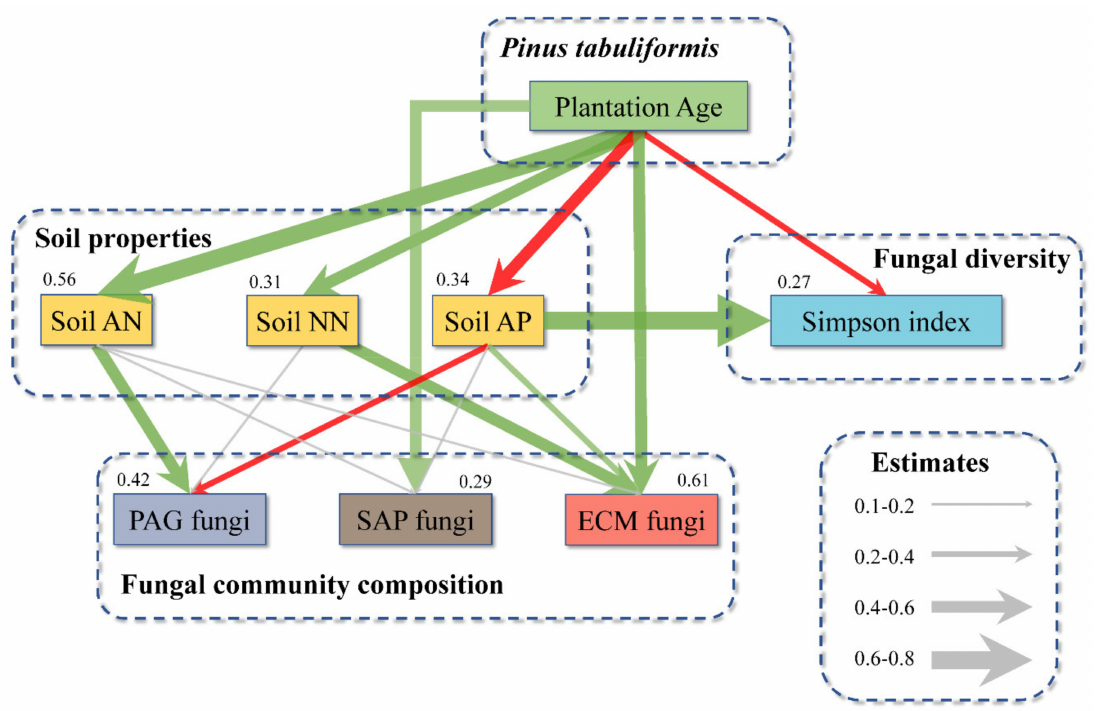
Figure 10. Structural equation model of the relationships among stand ages, soil properties, fungal community composition and fungal diversity ( p = 0.425, Goodness-of-fit index = 0.726, n = 27). The number on each component in the model is R 2 (the proportion of variance explained), the thickness of the arrow indicates the size of path coefficients, the green and red arrows indicate positive and negative correlations, respectively, and the gray arrow indicates no significant